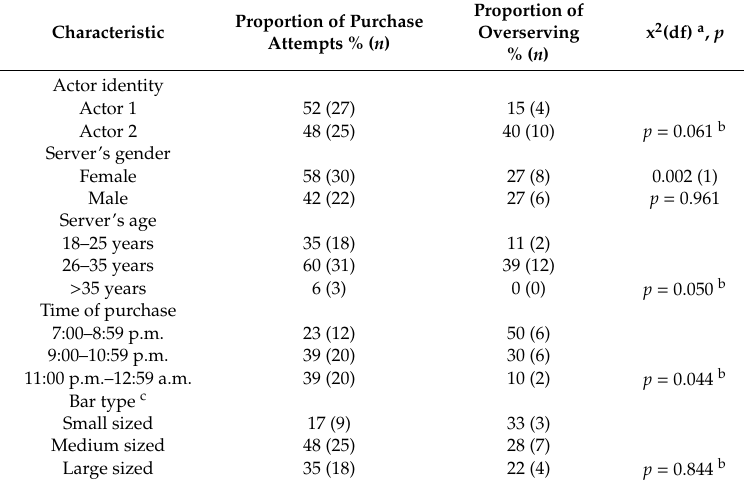
Table 1. Rates of overserving across various characteristics.